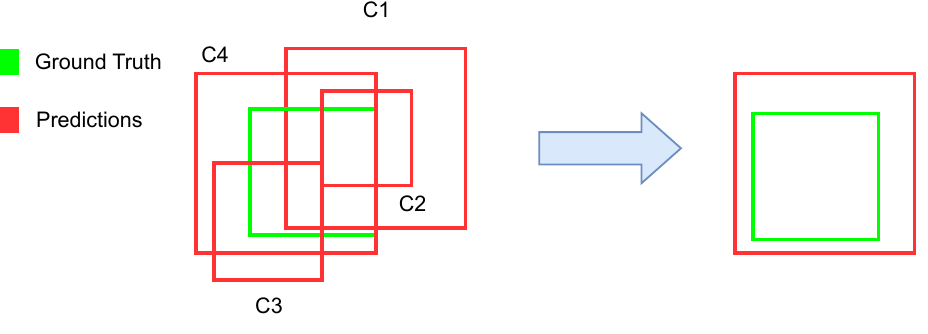
Figure 6. Schematic view of the Weighted Box Fusion algorithm. In this case C 1 > C 2 > C 3 > C 4